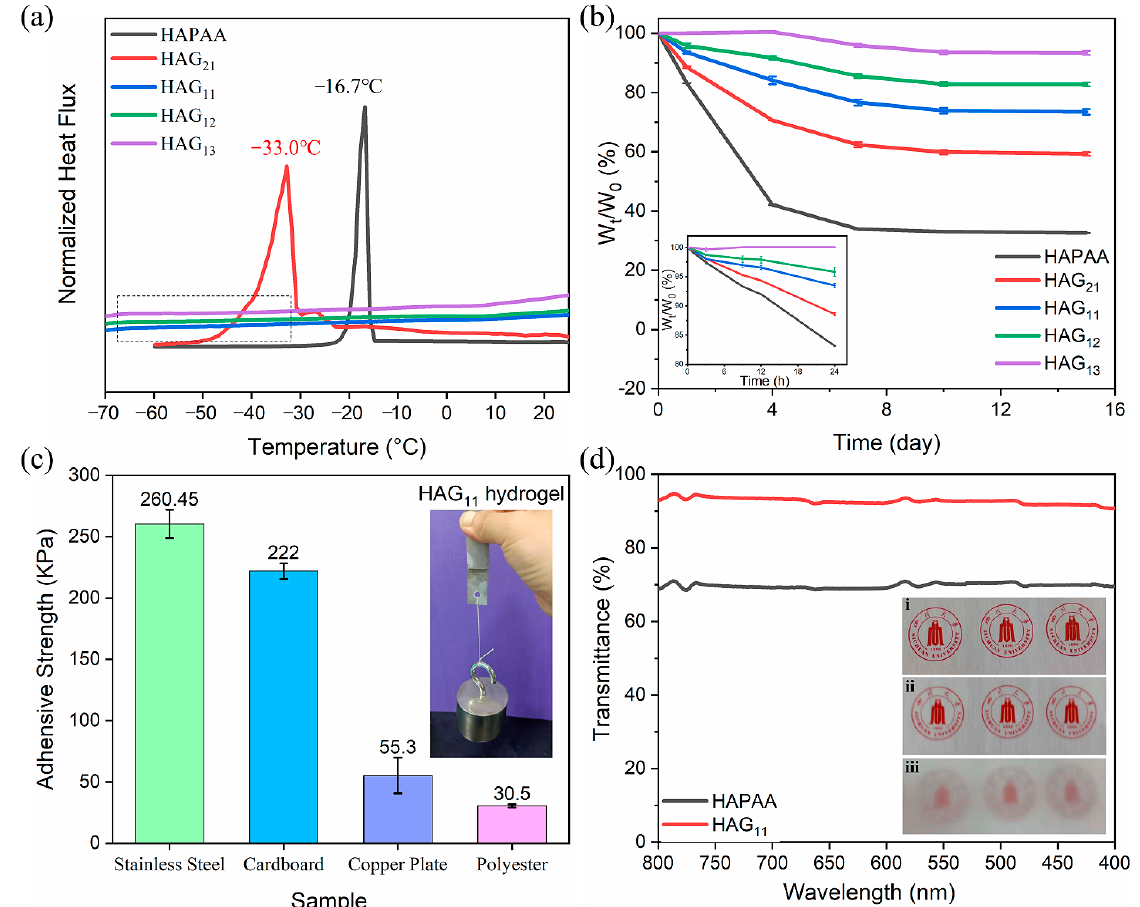
Figure 3. ( a ) DSC curves of HAPAA and HAG x hydrogels. ( b ) The water-retention of HAPAA and HAG x hydrogels with a testing time lasting for 15 days. ( c ) The adhesive strength of the HAG 11 hydrogel to different sample plates. The inset image shows the bonded plates of stainless steel lifted a weight of 1 kg. ( d ) The transmittance of HAPAA and HAG 11 hydrogels with a thickness of 2 mm. The inset images are (i) a real photo directly taken by a mobile phone, (ii) a photo taken by a mobile phone with the phone lens covered by HAG 11 hydrogel, and (iii) a photo taken by a mobile phone with the phone lens covered by HAPAA hydrogel.